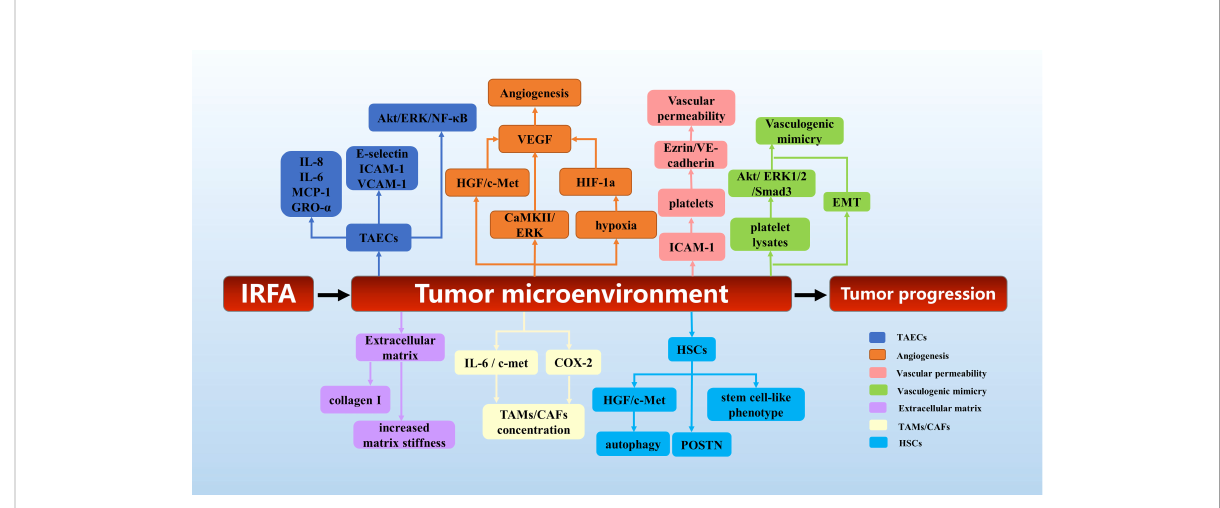
FIGURE 3 The mechanisms of tumor microenvironment in tumor progression after RFA of